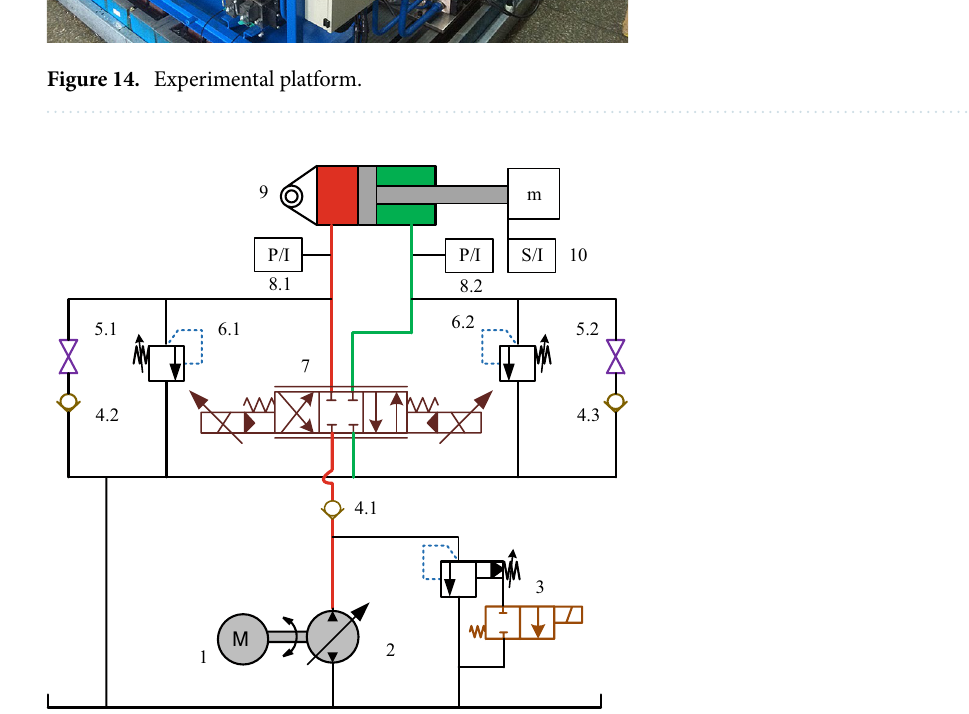
Figure 15. Schematic diagram of test rig hydraulic system (1. motor; 2. pump; 3. electromagnetic overflow valve; 4. check valve; 5. stop valve; 6. safety valve; 7. proportional direction valve; 8. pressure sensor; 9. double rod hydraulic cylinder; 10. displacement